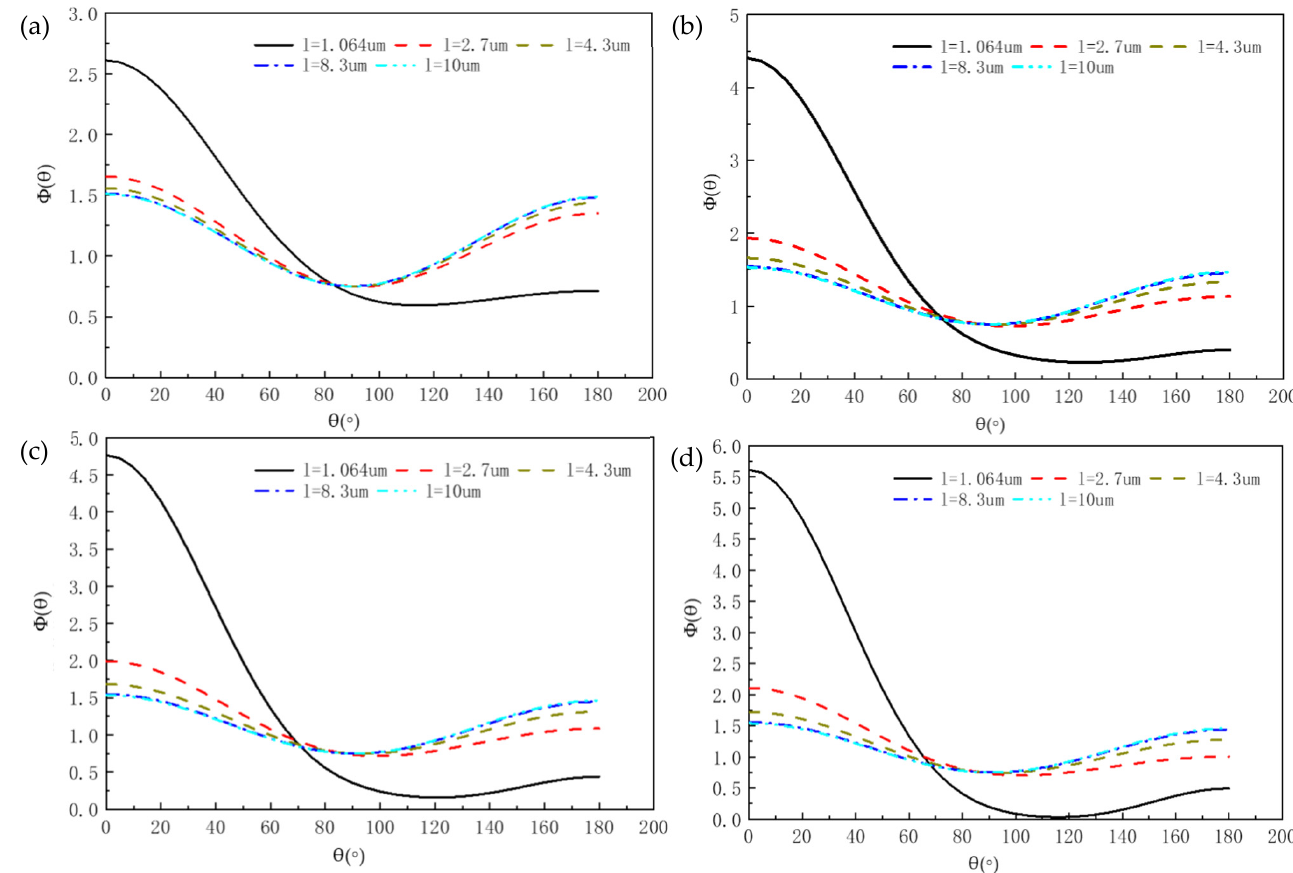
Figure 6. Scattering phase function of SiC particle changes with different cluster sizes at different wavelengths: ( a ) N = 20; ( b ) N = 50; ( c ) N = 70; ( d ) N = 100.